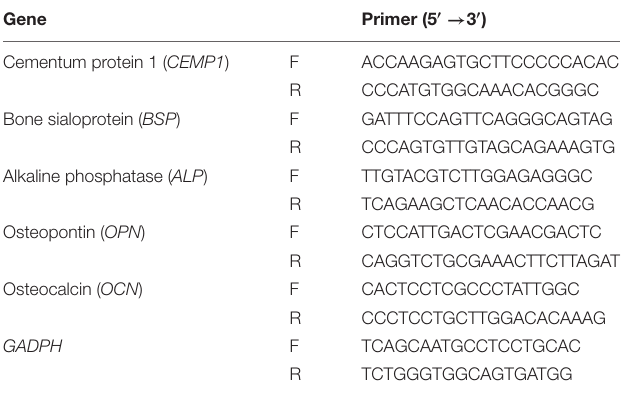
TABLE 1 | The primers for